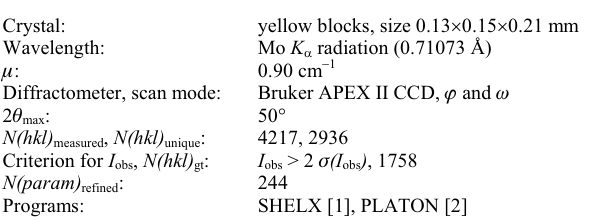
Table 1. Data collection and handling.